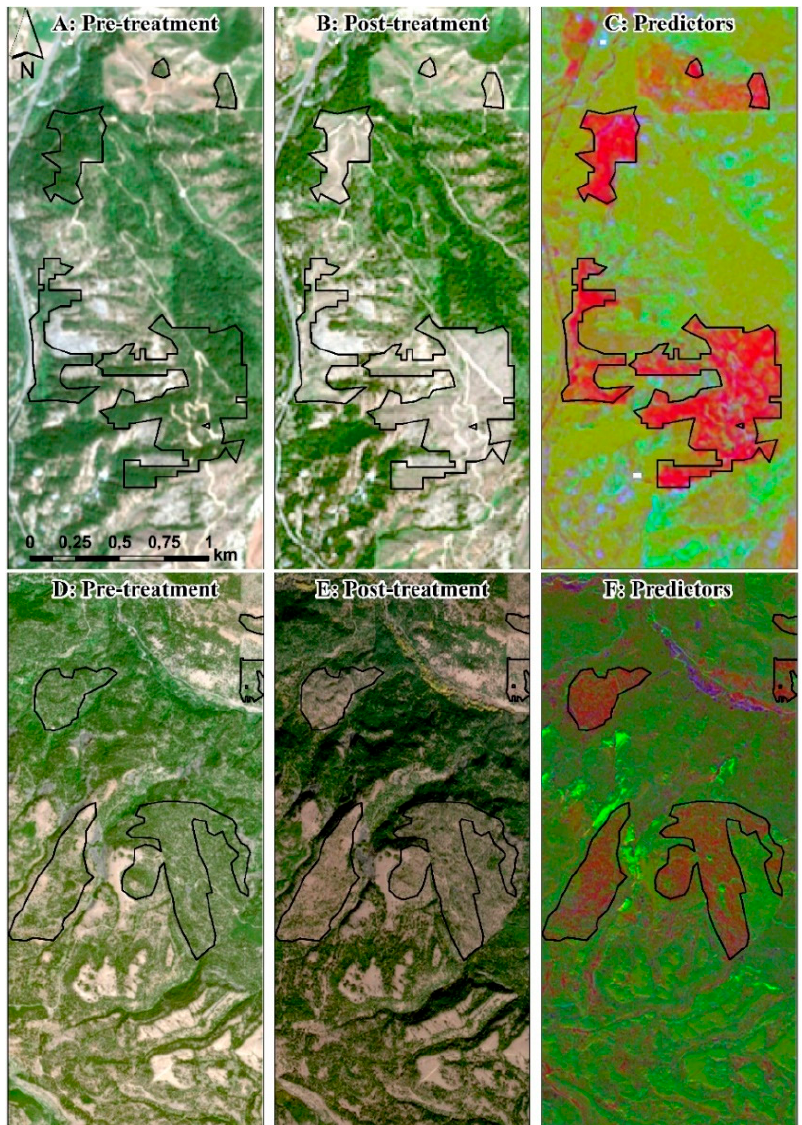
Figure 4. Initial identification of vegetation mechanical treatment units for: (a) clearcut (panels A – C ); Figure4. Initialidentificationofvegetationmechanicaltreatmentunitsfor: (a)clearcut(panels A – C );and and (b) thinning (panels D – F ). ( A ) and ( D ): Pre-treatment Sentinel-2 image on natural color; ( B ) and (b) thinning (panels D – F ). ( A , D ): Pre-treatment Sentinel-2 image on natural color; ( B , E ): post-treatment ( E ): post-treatment Sentinel-2 image on natural color; ( C ) and ( F ): predictor variables (Red: NDVI; Sentinel-2 image on natural color; ( C , F ): predictor variables (Red: NDVI; Green: RBR; Blue: first Green: RBR; Blue: first component of focal STD for PCA sub ). The black outline denotes the final component of focal STD for PCA sub ). The black outline denotes the final treatment perimeter, derived treatment perimeter, derived from the next steps of the analyses. from the next steps of the